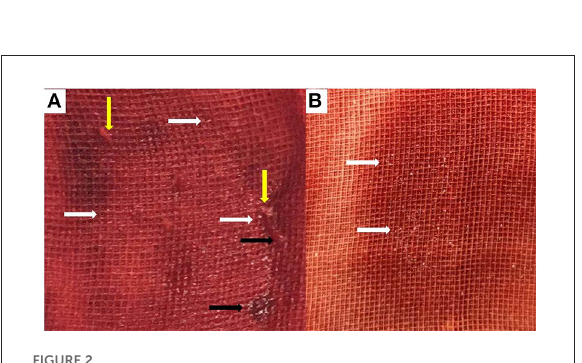
FIGURE2 The mixed components of drug debris, thrombosis, and plaque. The mixed components include drug debris [ (A,B) , white arrow], plaque debris [ (A) , yellow arrow], and thrombosis debris (black